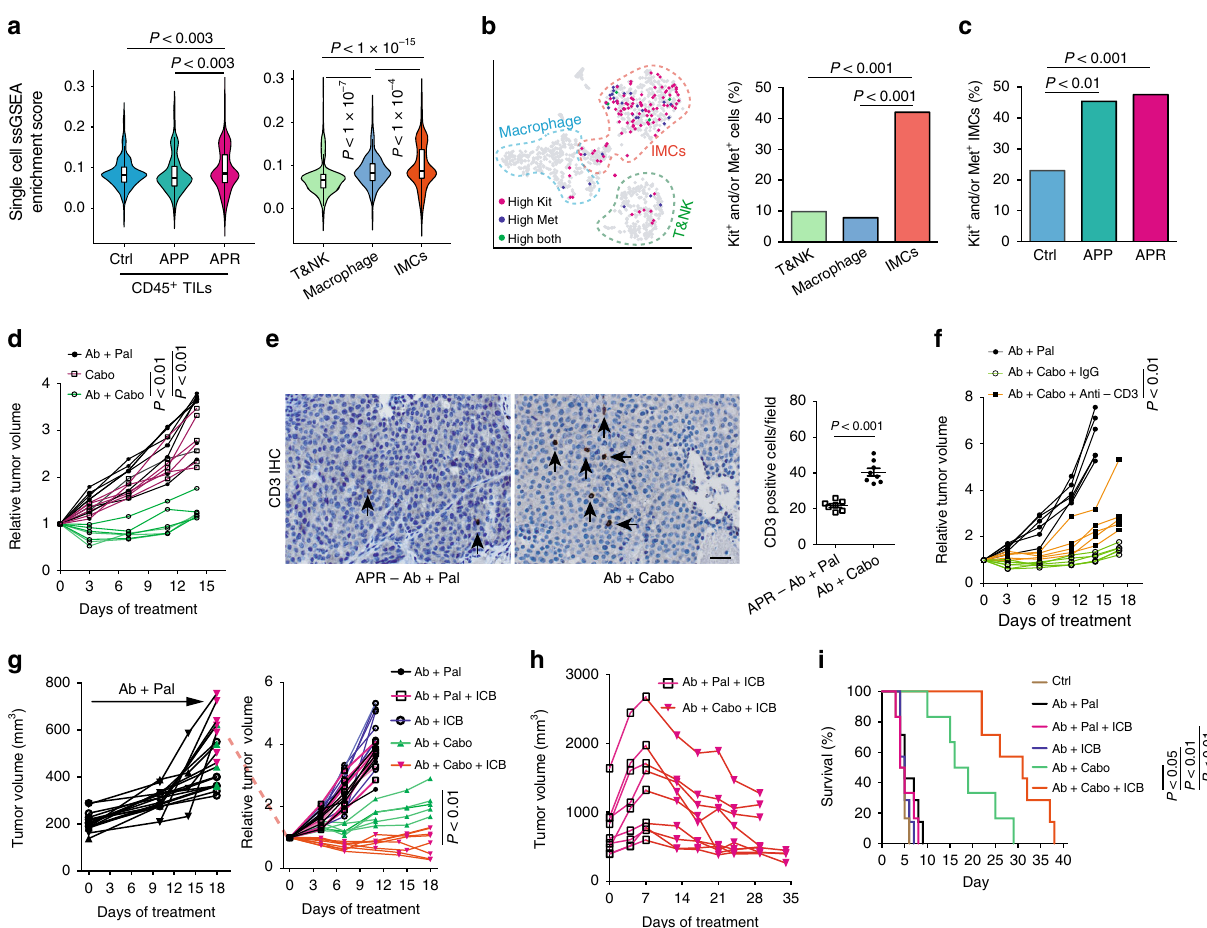
Fig. 3 Therapeutic strategy for anti-Her2 and Palbociclib resistant tumors informed by scRNA-seq analysis. a Enrichment analysis of cabozantinib target genes across single TILs grouped and plotted by different phenotypes (left) or by different immune cell types (right) as annotated in Fig. 2b. b Expression distribution of Kit and Met on t-SNE plot (left) and quanti fi cation of Kit and/or Met expressing cells among different immune cell types (right). c Abundance of Kit and/or Met expressing IMCs among tumors with different phenotypes. d Growth of APR tumors with Ab + Cabo treatment ( n = 7 for Ab + Pal, n = 6 for Cabo and n = 7 for Ab + Cabo). e Representative images and quanti fi cation of CD3 immunohistochemistry staining for tumors with Ab + Pal or Ab + Cabo treatment. Scale bar, 20 μ m. Error bars represent SEM. f T-cell depletion during Ab + Cabo treatment against APR tumors. g Relative volumes of APR tumors after treatment with Cabo and ICB. APR tumors were transplanted to recipient MMTV-neu mice and fi rst treated with Ab + Pal to acquire the resistance phenotype (left), then treated with Ab + Pal ( n = 6), Ab + Pal + ICB ( n = 6), Ab + ICB ( n = 8), Ab + Cabo ( n = 5), or Ab + Cabo + ICB ( n = 7) for 2 weeks (right). h Growth of APR tumors after sequential treatment with Ab + Pal + ICB and Ab + Cabo + ICB ( n = 9). APR tumors were treated with Ab + Pal + ICB for 1 week then switched to Ab + Cabo + ICB treatment for 3 weeks. i Survival time to doubled tumor volume of experiment in g . Cabo, protein kinase inhibitor cabozantinib. ICB, immune checkpoint blockades cocktail with anti-CTLA4 and anti-PD-1 mAb. P -value by Student ’ s t test in a , e , f , g , by three-sample Chi-square test in b and c , by one-way ANOVA with Tukey ’ s test in d , by log-rank (Mantel-Cox) test in